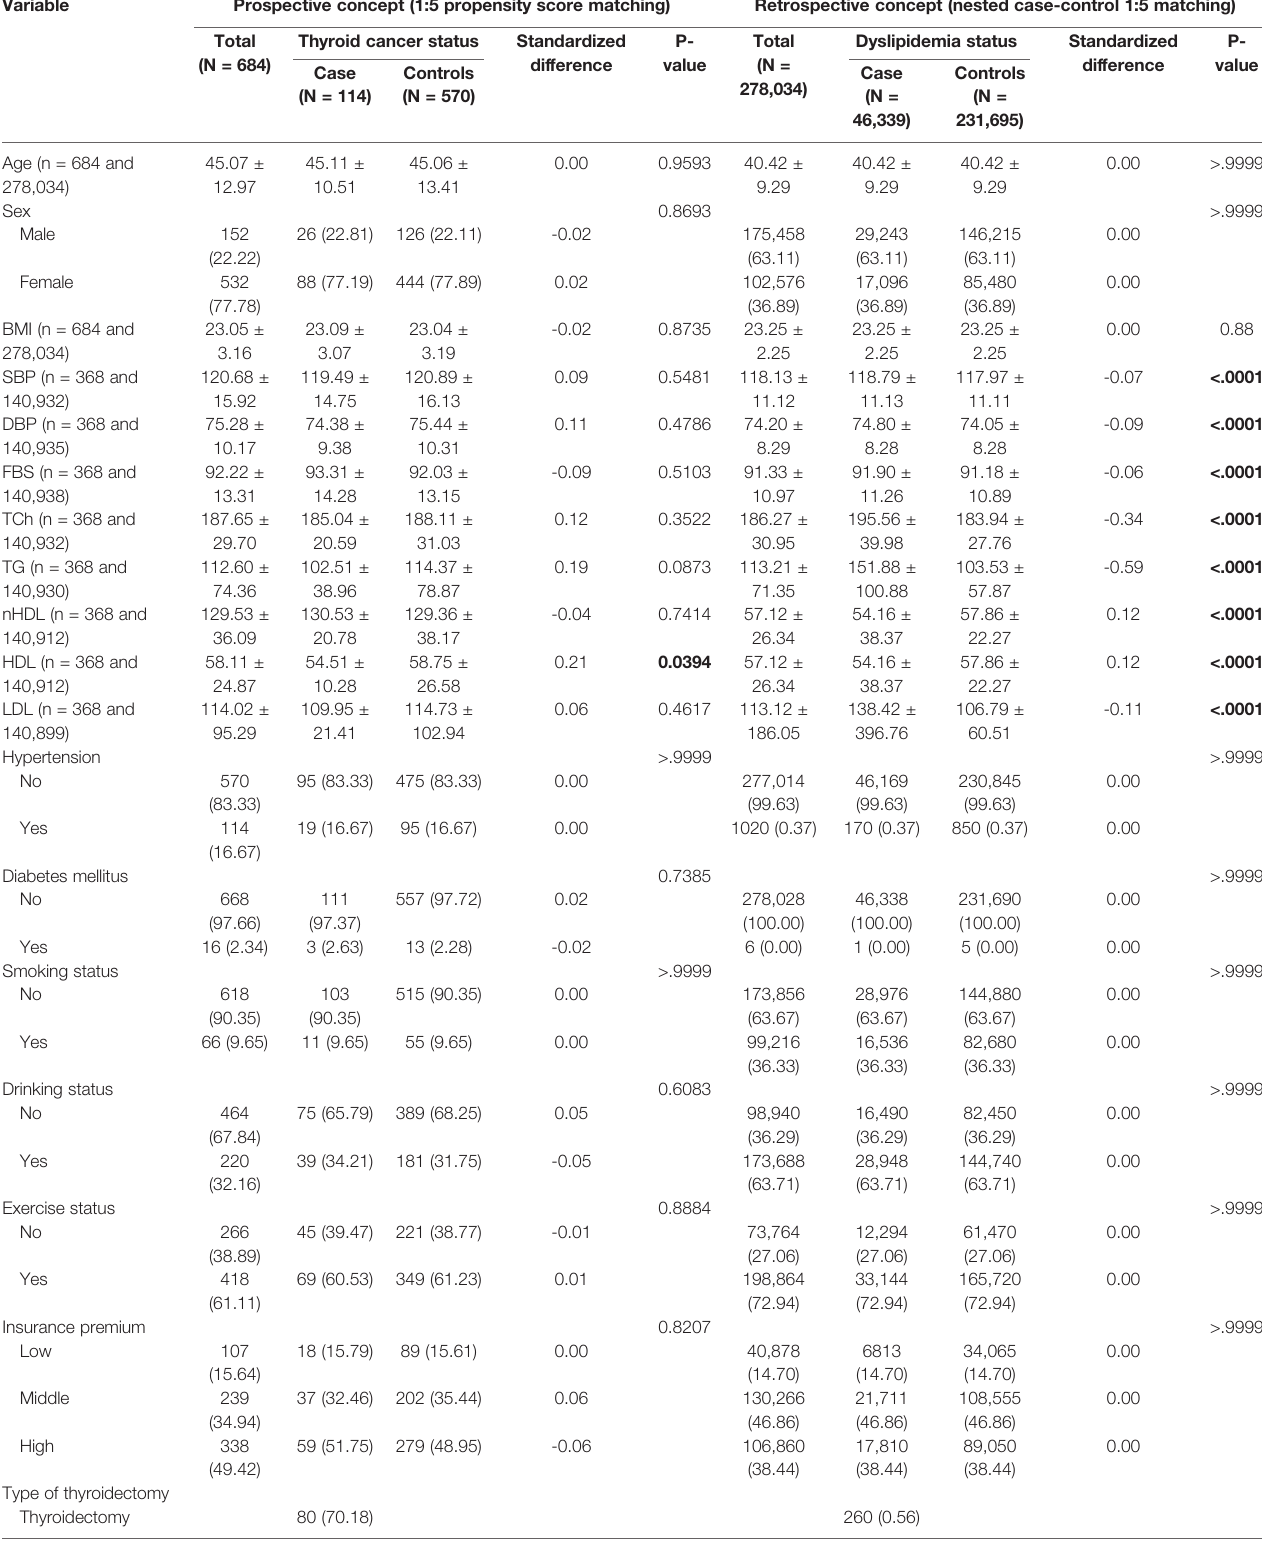
TABLE 2 | Characteristics of the prospective and retrospective analysis groups. Variable Prospective concept (1:5 propensity score